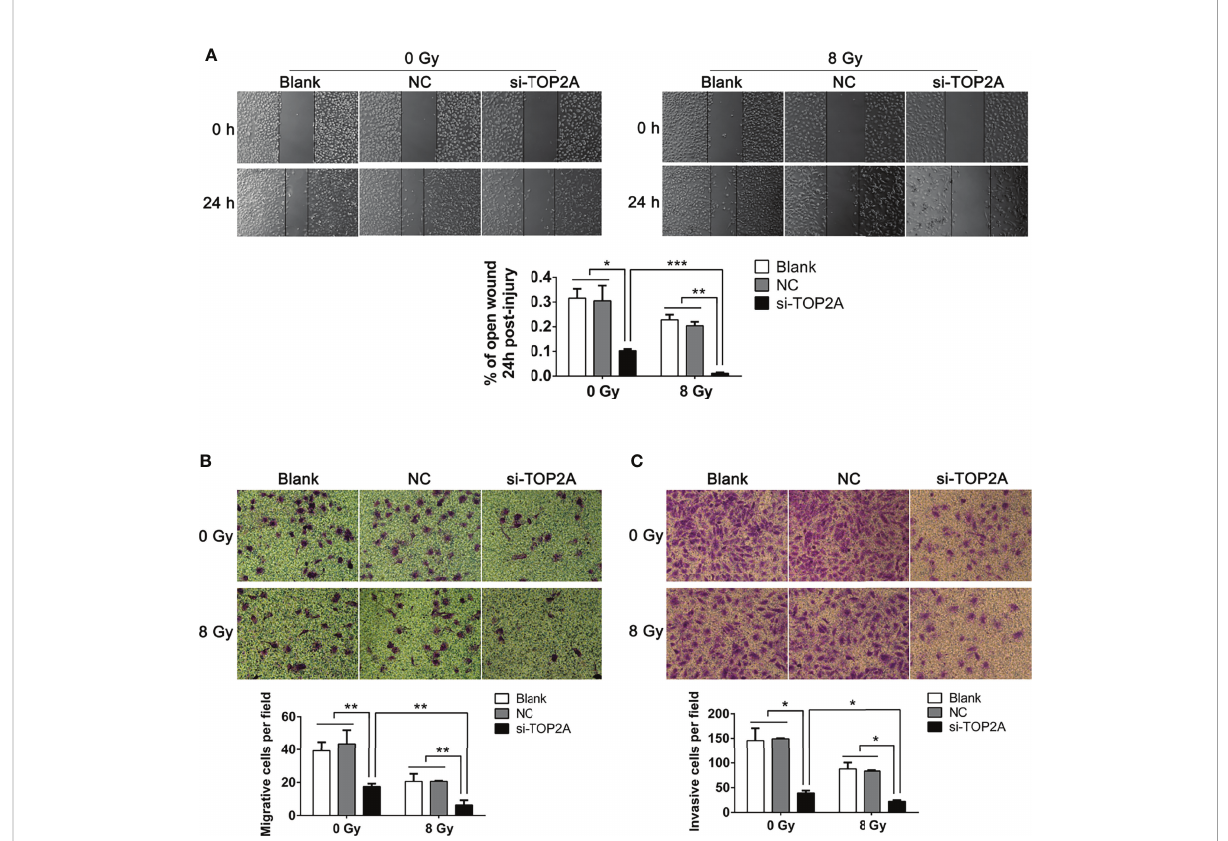
FIGURE 6 Downregulation of TOP2A inhibits MB cell migration and invasion. (A) Wound healing assays were performed to evaluate the migratory ability of si-TOP2A-transfected MB cells with or without exposure to 8 Gy IR. *P<0.05, **P<0.01, ***P<0.001. (B) Transwell assays were performed to assess the migratory ability of si-TOP2A-transfected MB cells with or without exposure to 8 Gy IR. **P<0.01. (C) Transwell assays precoated with Matrigel Matrix were performed to assess the invasive ability of si-TOP2A-transfected MB cells with or without exposure to 8 Gy IR.